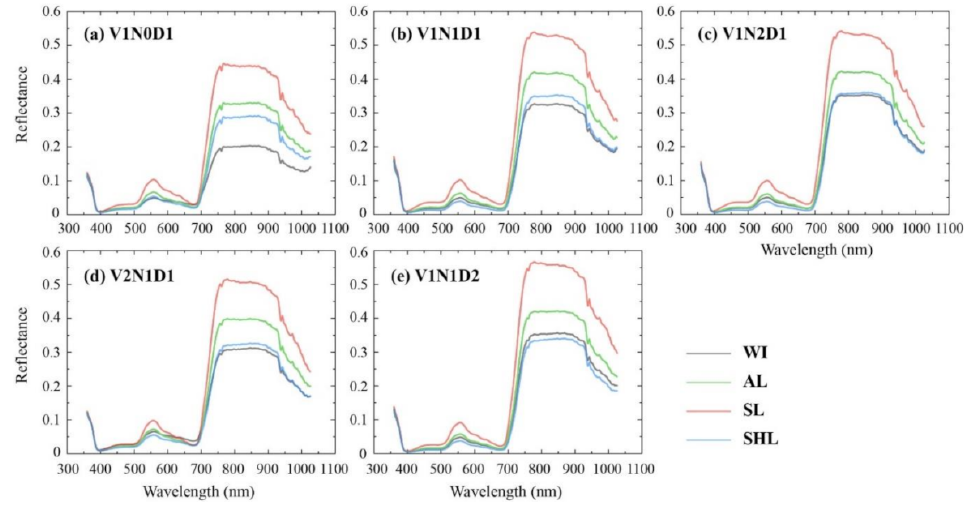
Figure 6. Changes in the reflectance of different objects under different conditions: ( a ) V1N0D1, ( b ) V1N1D1, ( c ) V1N2D1, ( d ) V2N1D1, and ( e ) V1N1D2. The descriptions of different conditions are provided in Table